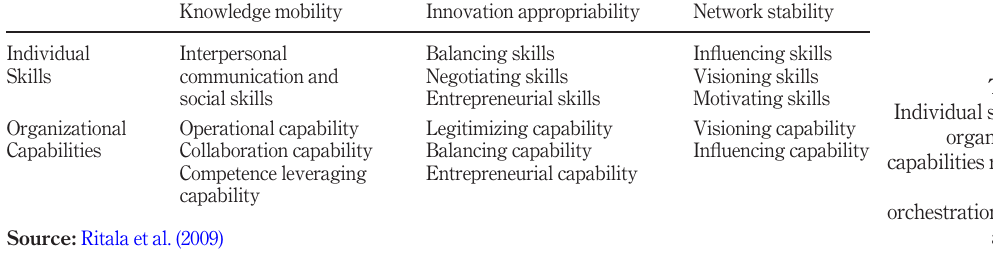
Table 1. Individual skills and